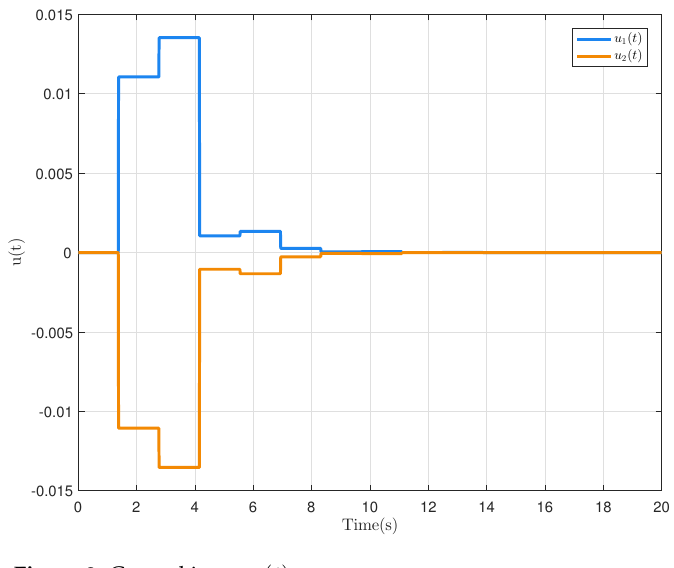
Figure 2. Control input u ( t ) .